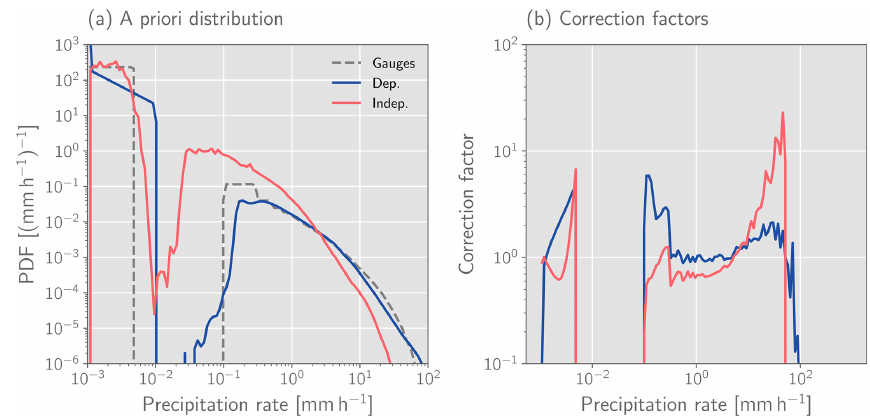
Figure 6. A priori distributions of hourly accumulations and derived correction factors r for the Hydronn 4 , All retrieval. Panel (a) displays the a priori distributions of hourly precipitation accumulations derived assuming strong temporal dependence of measurements (blue) and com- plete independence (red). The dashed grey line shows the PDF of the gauge measurements. Panel (b) displays the corresponding correction factors for the two assumptions calculated as the ratio between the respective PDFs and the PDF of the gauge